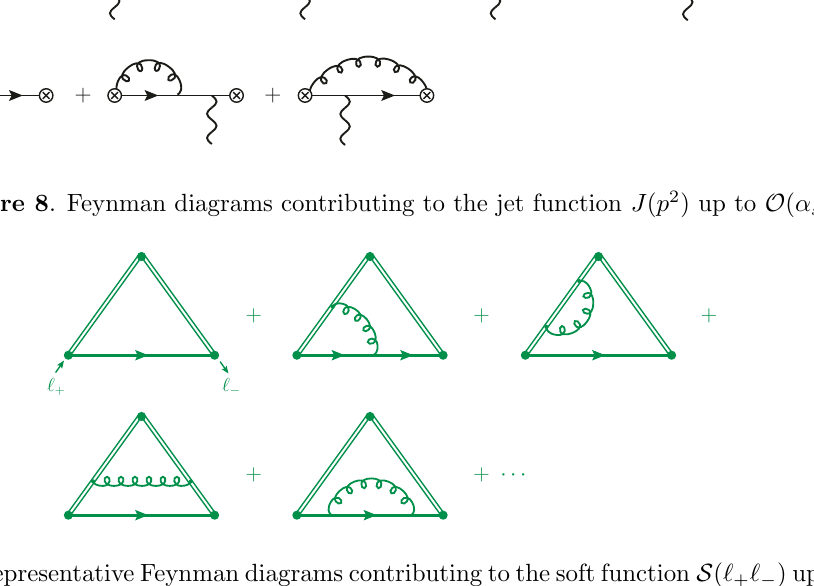
Figure 9 . Representative Feynman diagrams contributing to the soft function S ( ‘ + ‘ (cid:0) ) up to O ( (cid:11) s ). We omit the mirror graphs of the second and third diagram, in which the gluon is attached to the other Wilson line. The soft function S ( ‘ + ‘ (cid:0) ) in (2.32) is given by the discontinuity of S ( ‘ + ‘ (cid:0)